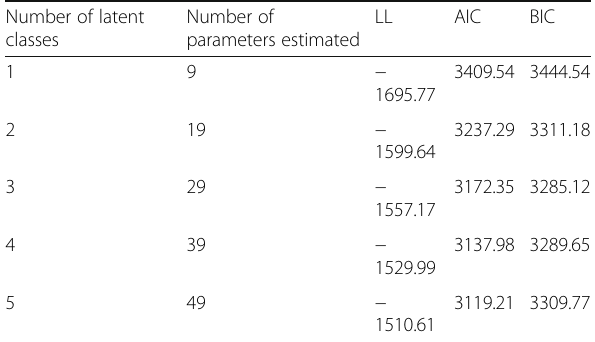
Table 2 Fit statistics for latent class analyses Number of latent classes